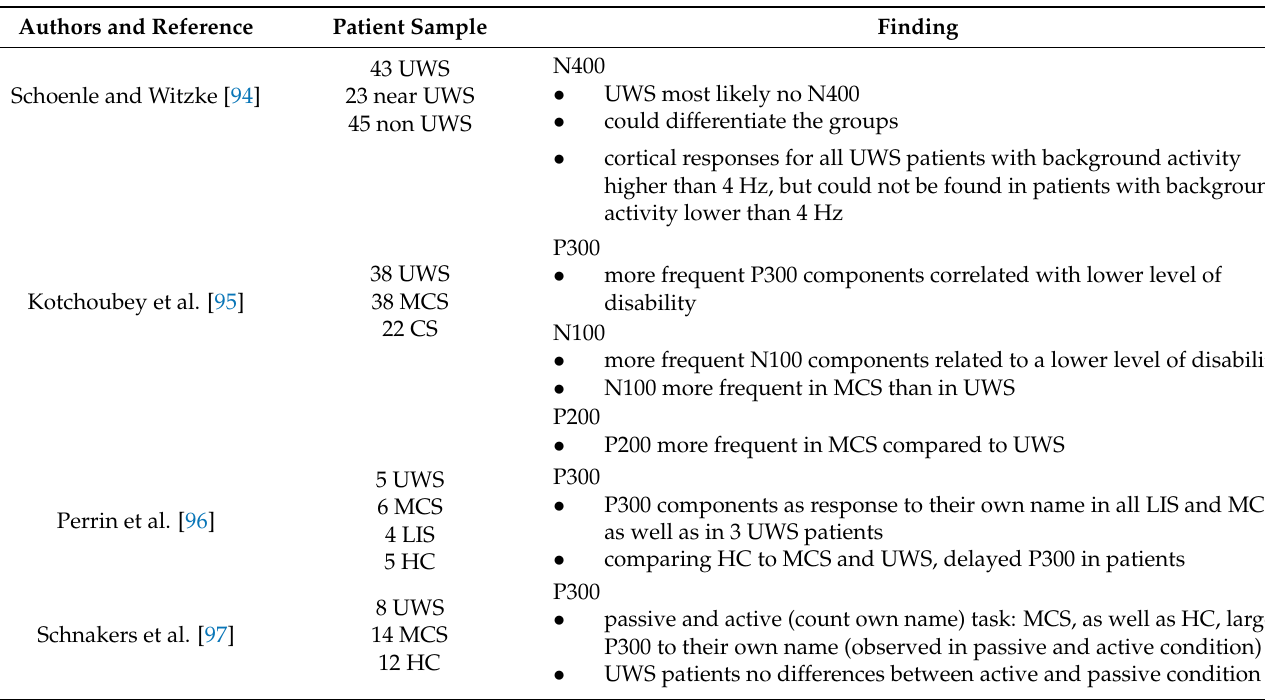
Table 3. Overview of findings for diagnosis and evoked potentials; abbreviations can be found in Abbreviation. Authors and